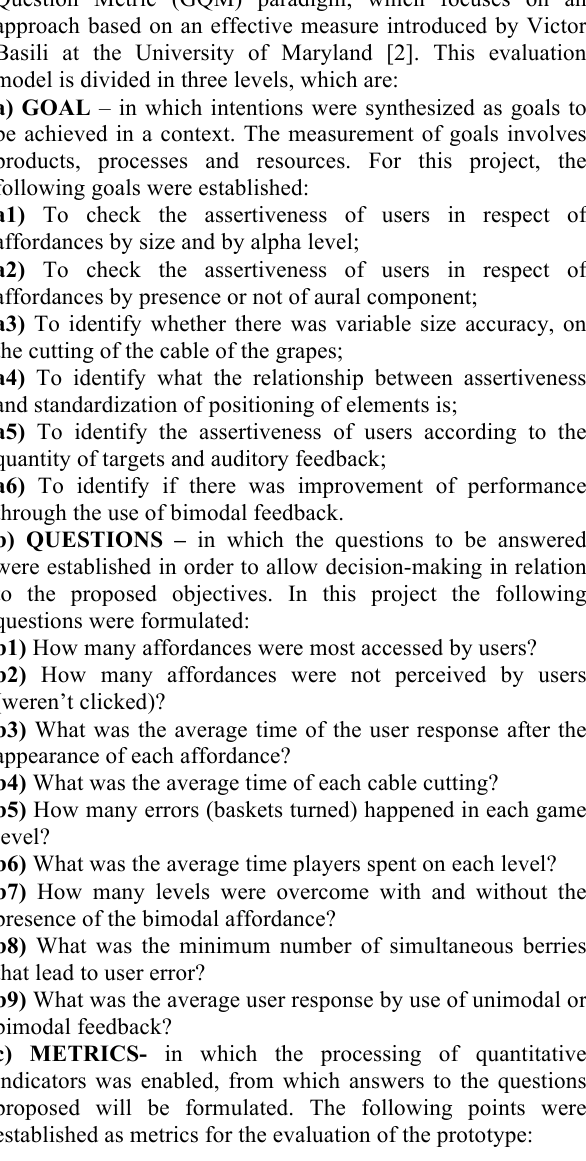
Fig 8. The test for the application with elderly